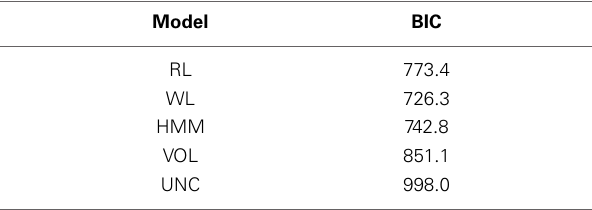
Table 1 | Calculated BIC for all models using all participants.